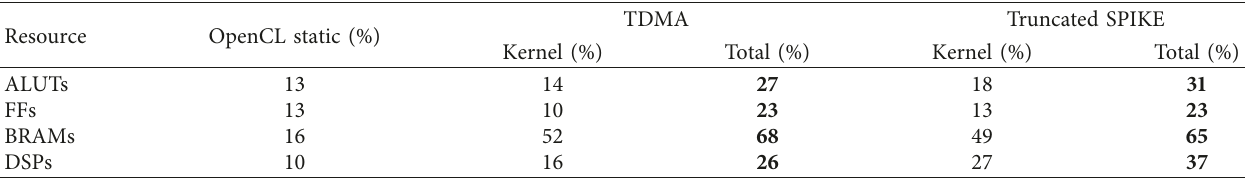
Table 2: FPGA hardware utilisation for the OpenCL static portion, TDMA, and truncated SPIKE kernels, and total utilisation for each implementation (static +